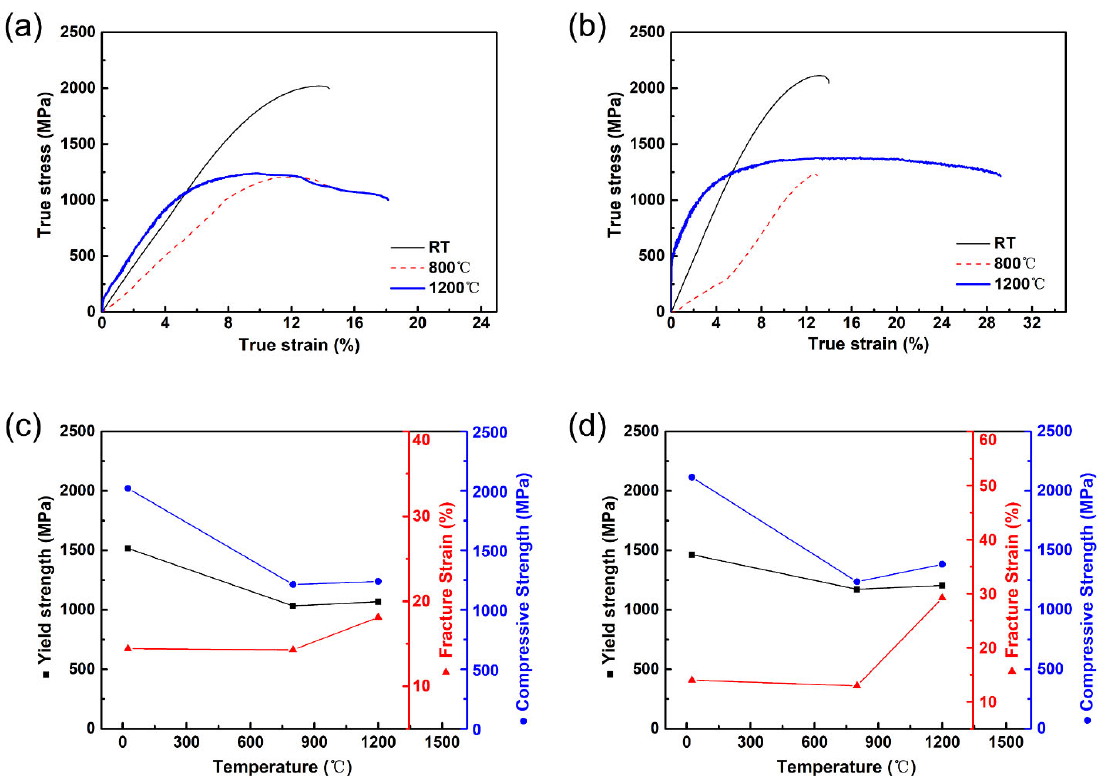
Figure 4. The true strain–stress curves of ( a ) W0.7 and ( b ) W0.9 at different temperatures, temperature dependences of yield strength, compressive strength, and fracture strain of ( c ) W0.7 and ( d ) W0.9. The relationship between temperature and mechanical properties of W0.7 and W0.9 was different represented in Figure 4c,d, respectively. The results show that the yield strength of W0.7 and W0.9 decreased 31.91% (from 1517 MPa to 1033 MPa) and 19.95% (from 1464 MPa to 1172 MPa) when the temperature increased from RT to 800 °C, which was mainly attributed to thermal softening. With the addition of WC, W0.9 exhibited superior thermal softening re- sistance compared with that of W0.7. It is speculated that more ceramic phases improved the heat endurance of the composites. The synergetic enhancement of strength and ductility was achieved when the temperature was raised from 800 °C to 1200 °C, and the improvement range was larger in W0.9, which was due to C doping and solid solution strengthening. Table 3. True compressive mechanical properties of the MoNbTa(WC) 0.7 and MoNbTa(WC) 0.9 at dif- ferent temperatures.